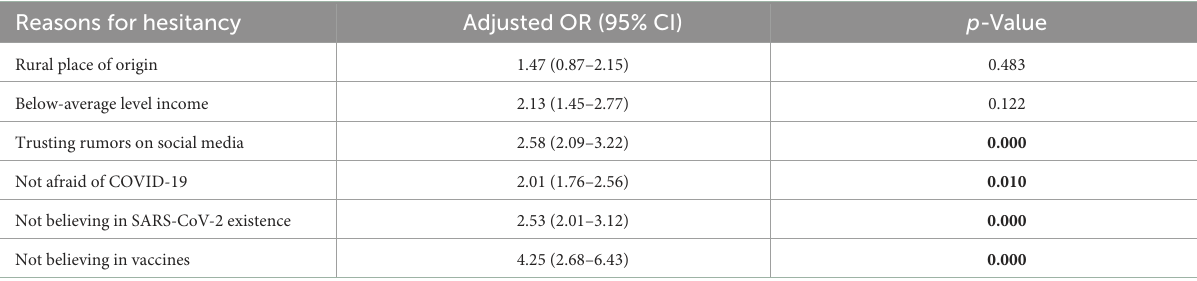
TABLE 5 Analysis for adjusted odd ratios of the potential factors associated with hesitancy among pregnant women. Reasons for